Question: Write a single sentence explaining what this figure depicts.
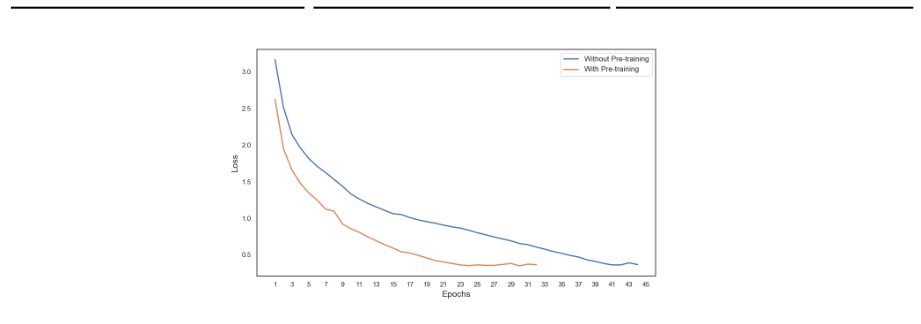
Answer: Convergence rate of SketchGPT with and without pre-training.